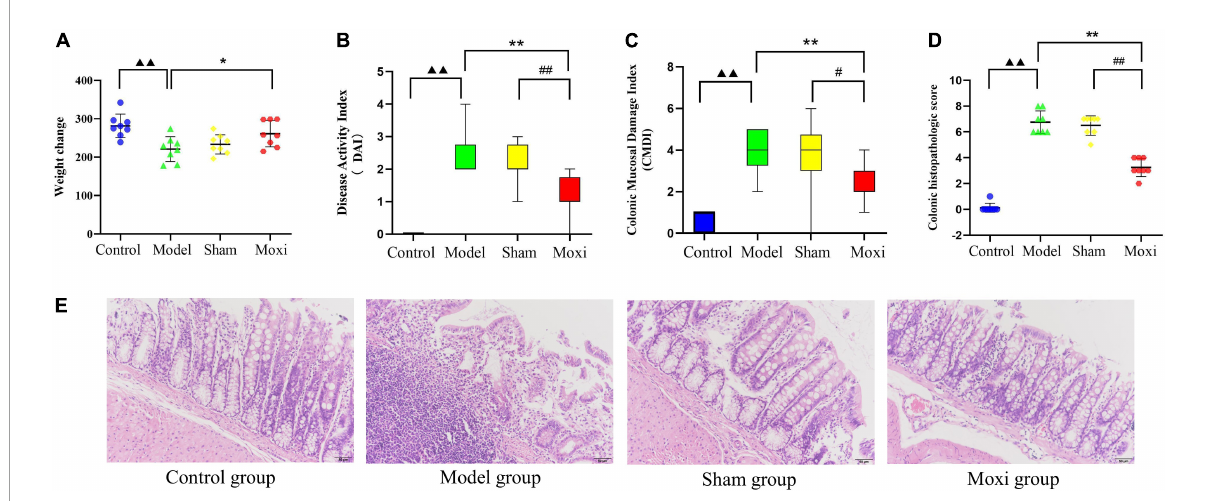
FIGURE2 Effect of moxibustion on weight gain and improvement of intestinal inflammation levels. (A) Change in body weight, (B) Disease activity index (DAI) score, (C) Colonic Mucosal Damage Index (CMDI) score, and (D) Colonic histopathologic score. (E) Hematoxylin-eosin (HE)-stained sections of colon tissue of rats in each group. n = 8 per group. (cid:78)(cid:78) P < 0.01 vs. control group; * P < 0.05, ** P < 0.01 vs. model group; # P < 0.05, ## P < 0.01 vs. sham